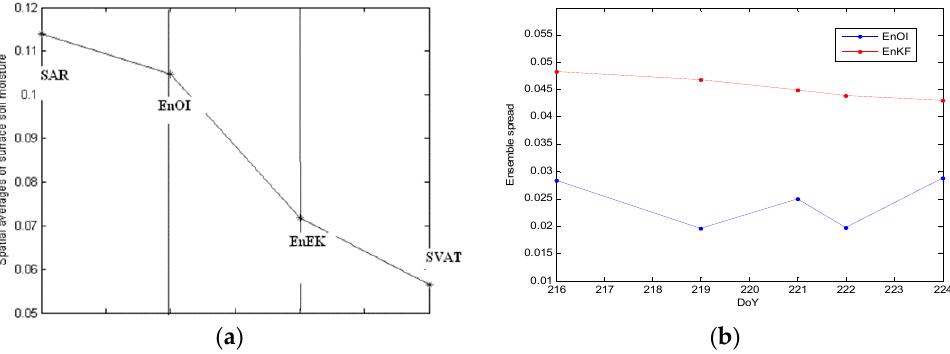
Figure 8. ( a ) Spatial average of surface soil moisture (m 3 /m 3 ); ( b ) Ensemble evolution of EnOI and EnKF.